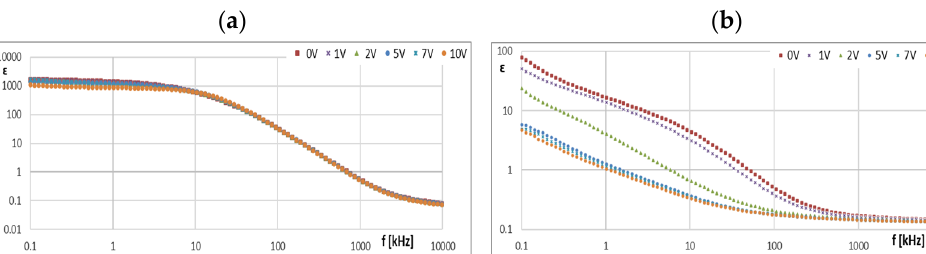
( ε ) on the frequency ( f ) for the CJ008 sample in the BIAS field of low voltage (0~10